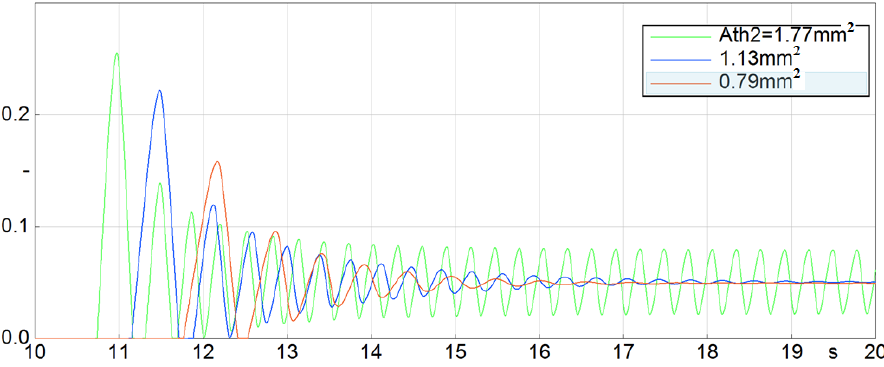
Figure 11. Valve displacement y 1 for various area of throttle 10 ( A th 2 ) with a stepwise increase of the area of metering valve 8 at the constant values of area of throttle 11 A th 1 = 1.77 mm 2 , leakage Q leak = 11 l / min , and outlet cavity stiffness β out = 3.3 · 10 − 3 .